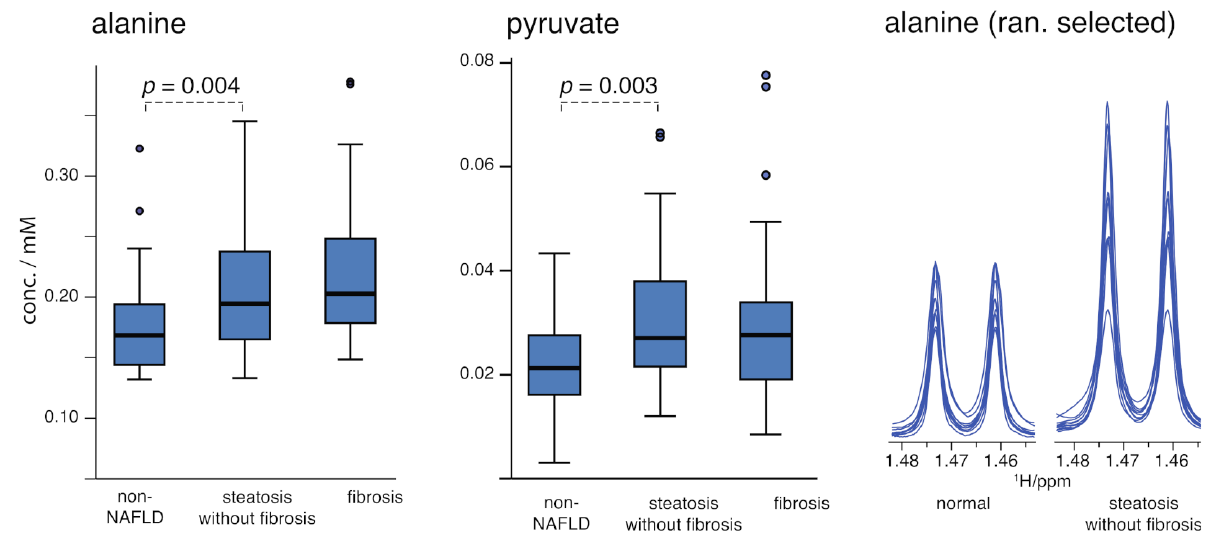
Figure 3. Boxplots of alanine and putative pyruvate concentrations are shown as a function of group membership. In the final panel, the spectral region corresponding to the doublet from the methyl sidechain is depicted for 10 randomly selected spectra in each of two groups to illustrate the practical spectral differences. Multiply concentrations by 2 for the serum